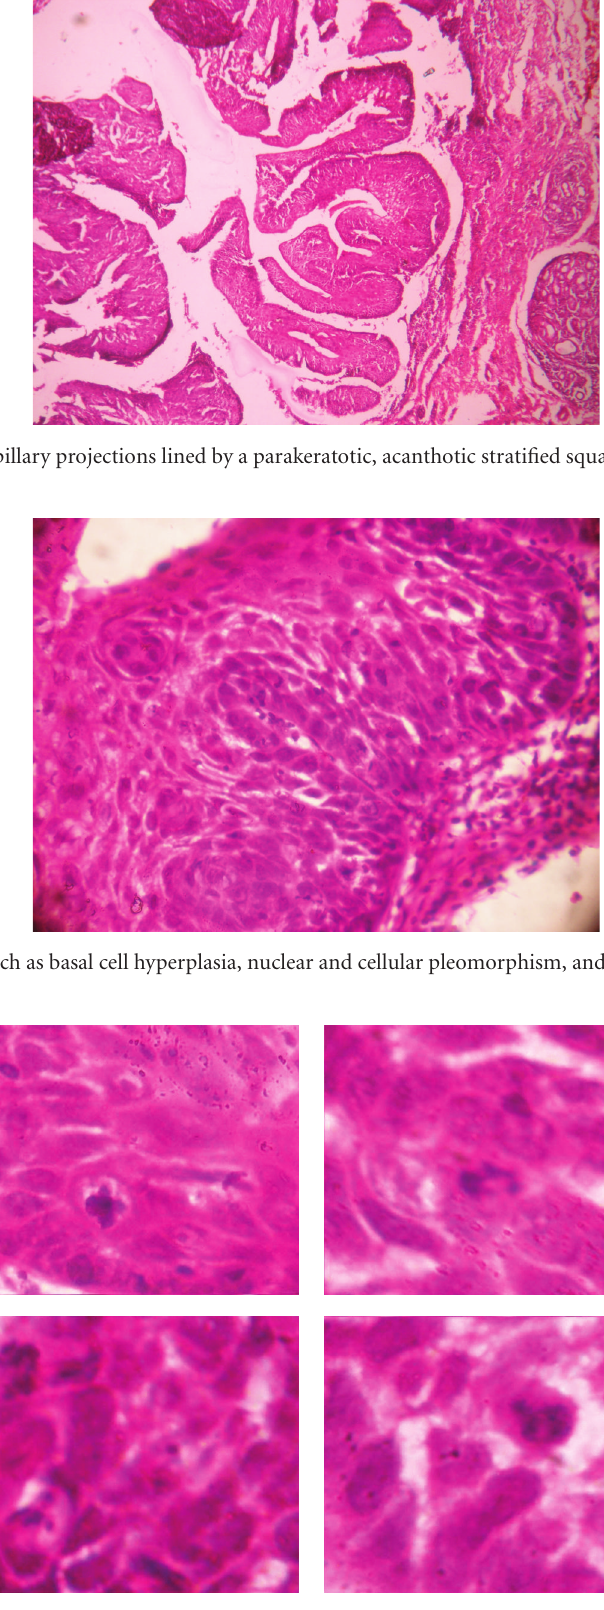
Figure 3: Mitotic figures under oil immersion